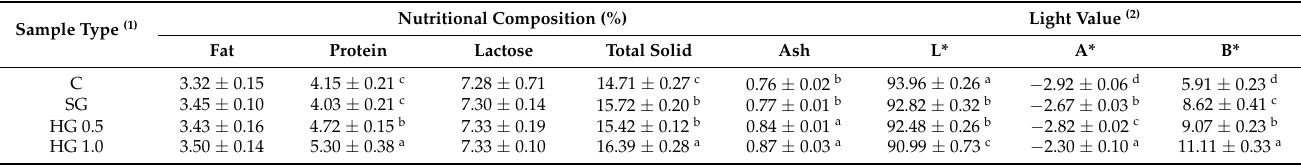
Table 1. Physicochemical properties of ginseng extract-fortified